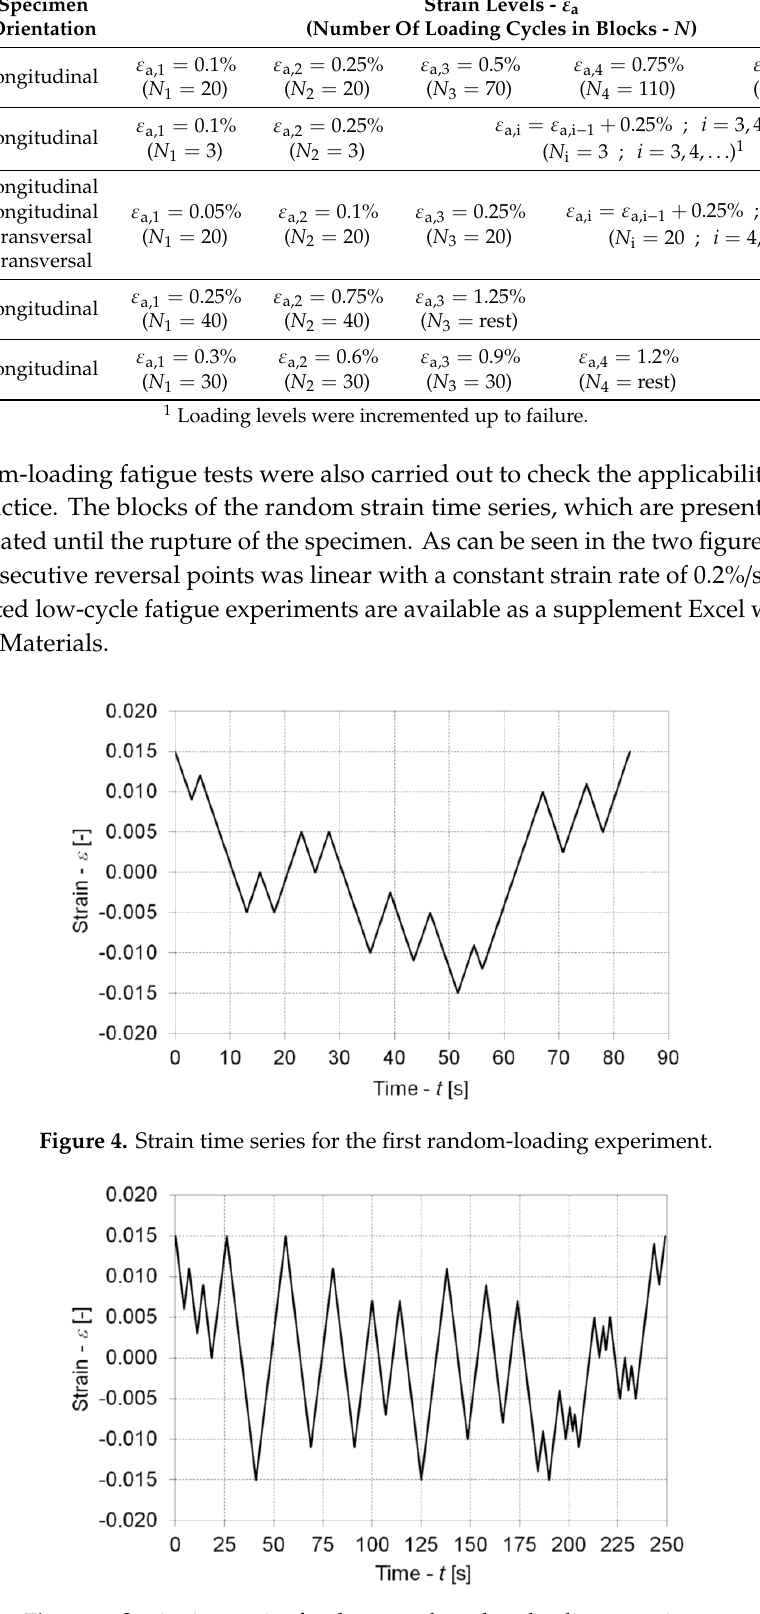
Table 1. Step-strain low-cycle fatigue experiments.